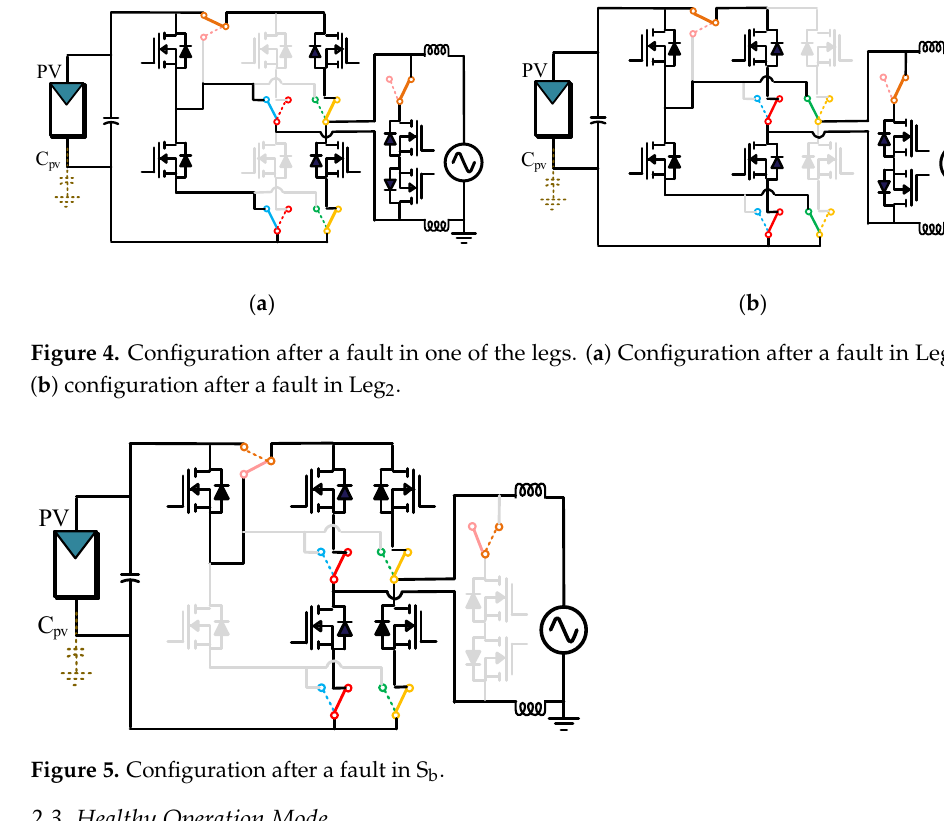
Figure 3. Configuration in the healthy mode of the IFTPVI.